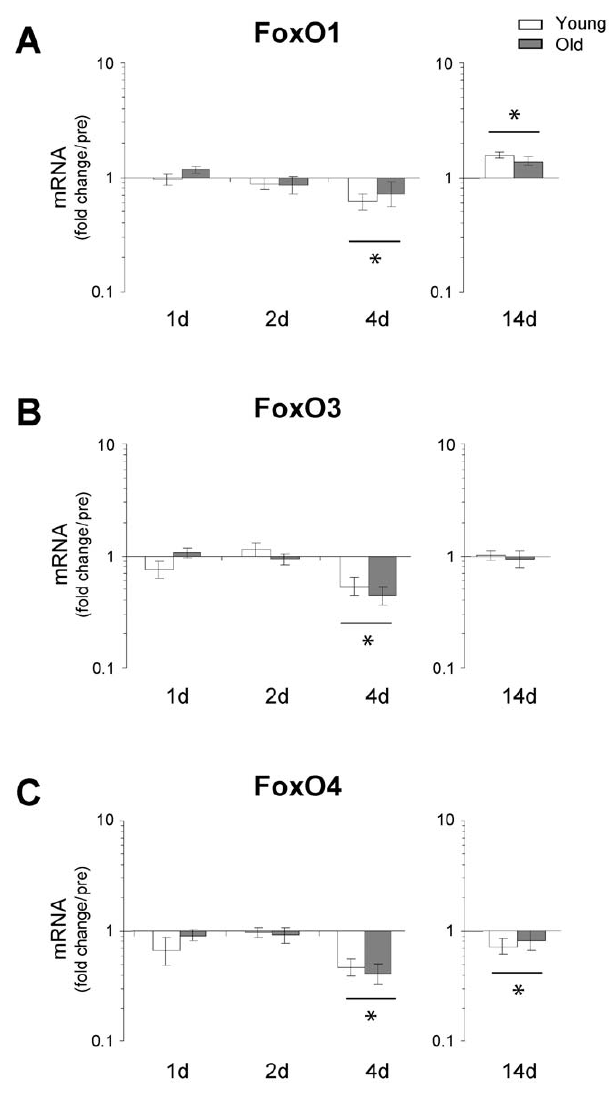
Figure 5. Changes in the transcriptional status of FoxO1, FoxO3 and FoxO4 as a result of immobility-induced muscle disuse. A–C. The mRNA level of FoxO1, FoxO3 and FoxO4 was determined using qRT-PCR. No up-regulation in the mRNA expression levels in any of these three genes was observed during the initial phase of immobility, in contrast, a general down-regulation in all three genes was observed in both young and aged muscle at the 4 d time point, potentially reflecting a negative feedback signal from high presence of active FoxO protein in the muscle cell. However, it is difficult to interpret the role of FoxO in the present study since the phosphorylated forms of FoxO were not measured. * Time effect, p , 0.05 bar indicates young and old within time point. Data are geometric means 6 back- transformed SEM.